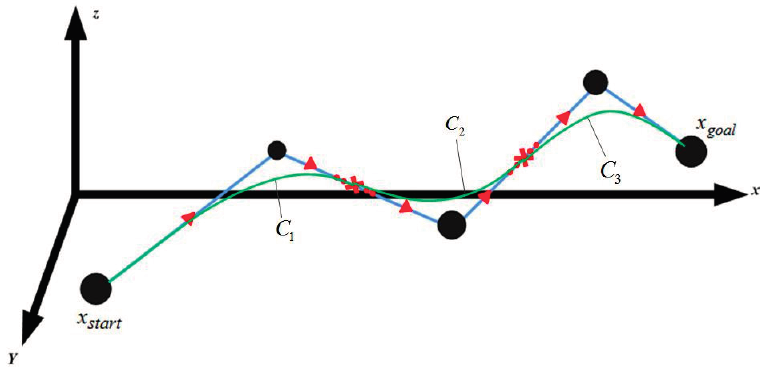
Figure 9. Result of the sixth-order Bezier curve C 3 constituted by the nodes { 3 N 0 , 3 N 1 , l , 3 N 6 }.